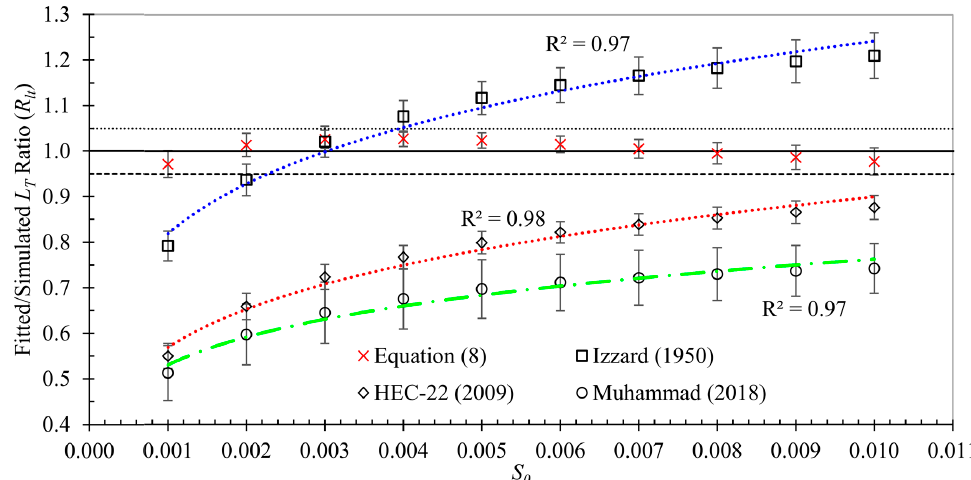
Figure 5. The mean ratio R lt of fitted/predicted and simulated L T as a function of longitudinal slope S 0 for 1000 modeling cases with standard deviations.